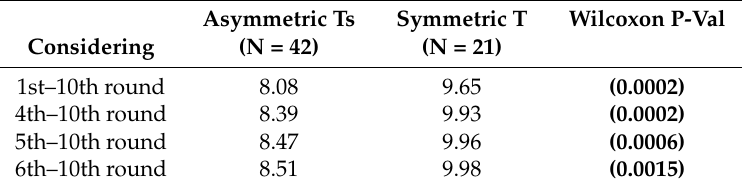
Table A1. Average Actual Trade in Asymmetric and Symmetric Treatments.